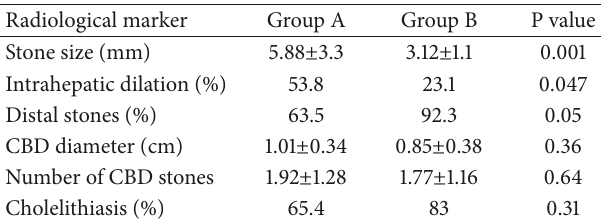
Table 4: Comparison of blood tests at admission: groups E and D.